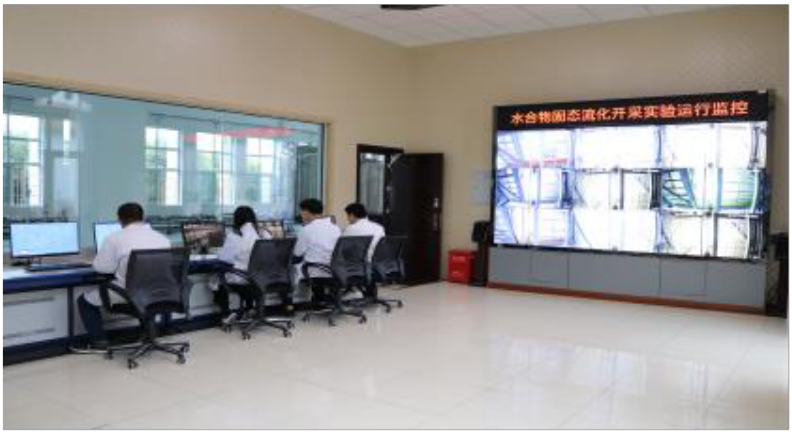
Figure 3. The real-time image capture, data acquisition, and automation module of safety control.